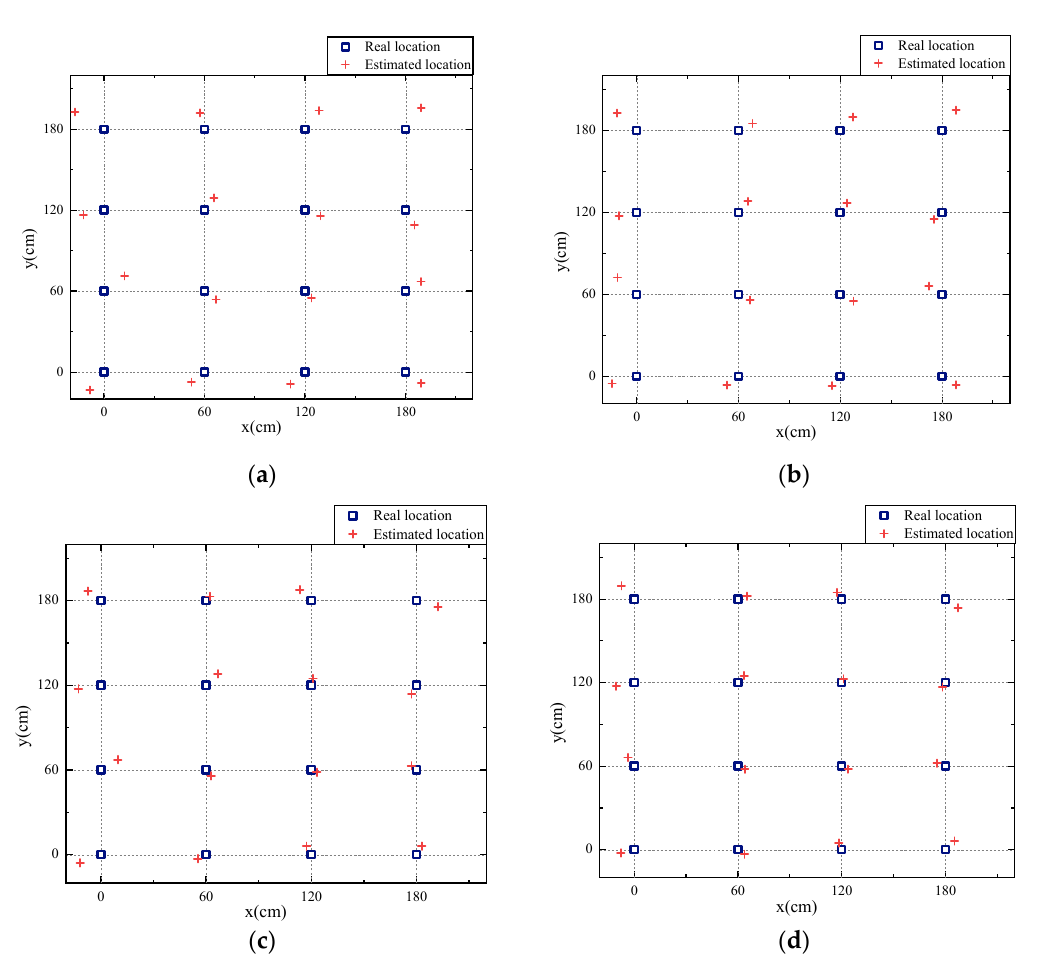
Figure 15. Coordinate plot of the calculated estimated value of the precise positioning algorithm against the true value for different values of h: ( a ) h = 40 cm; ( b ) h = 60 cm; ( c ) h = 80 cm; ( d ) h = 100